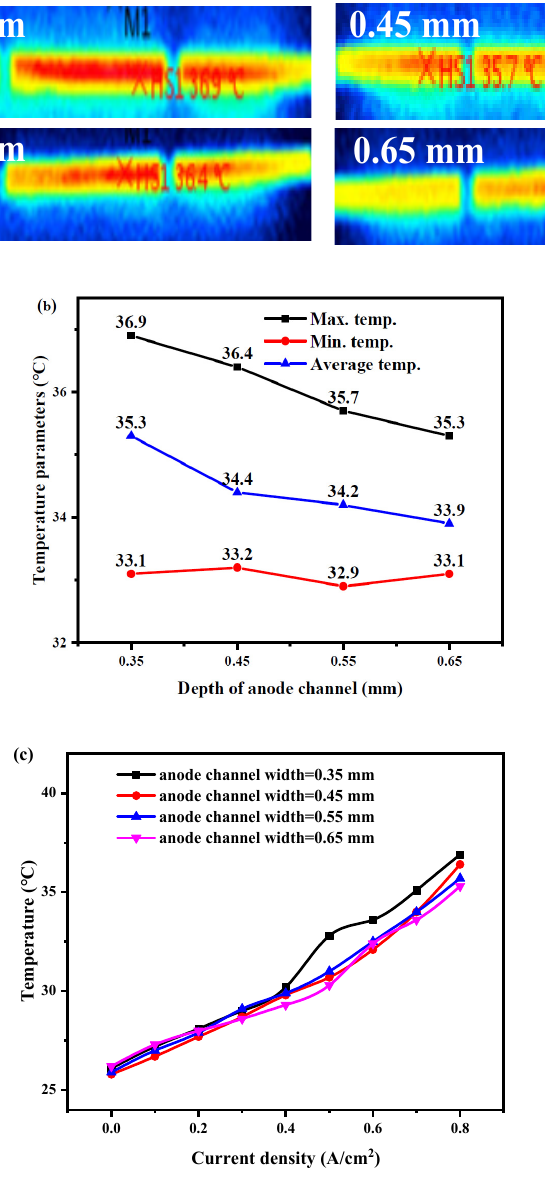
Figure 8. ( a ) Temperature distribution at 0.8 A/cm 2 , ( b ) maximum, minimum, and average temperatures, and ( c ) variation of hot spot temperature with current densities of the open-cathode PEMFC with different anode serpentine channel widths.